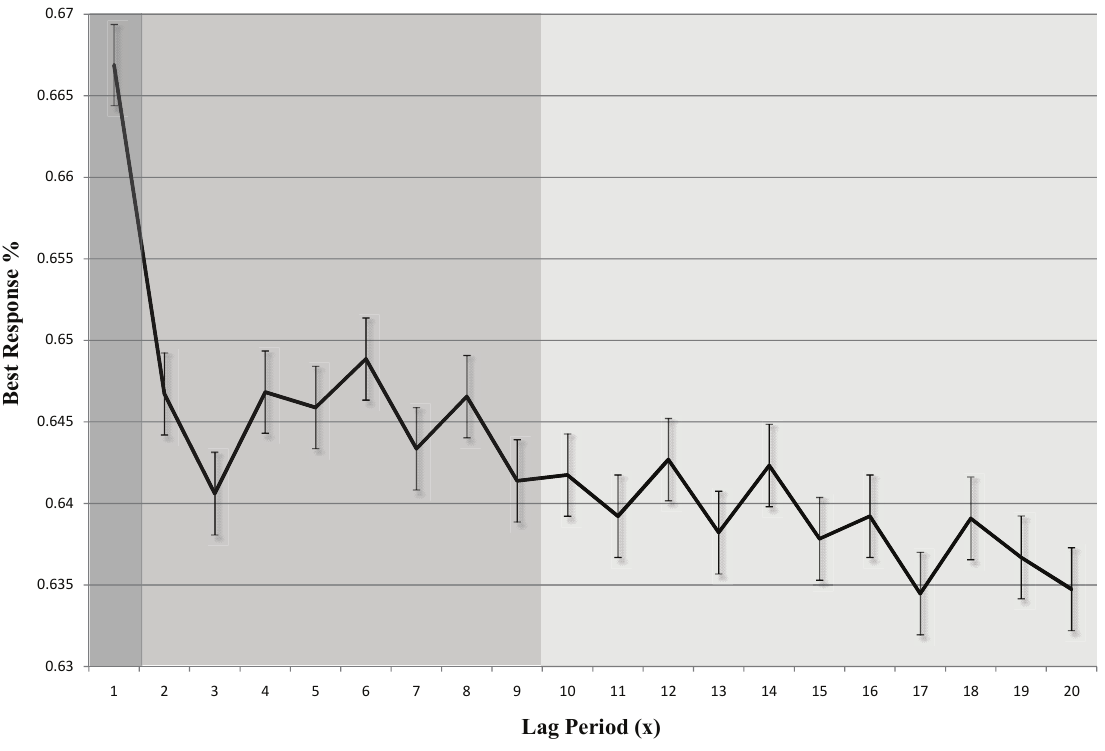
Figure 1. Best response